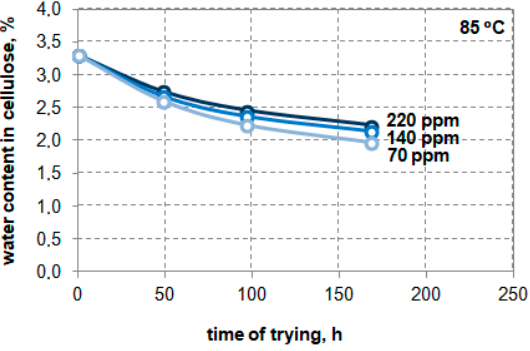
sample thickness 3 mm, ester with a moisture content of 70 ppm was introduced three times, the mass ratio of cellulose to ester 0.067.